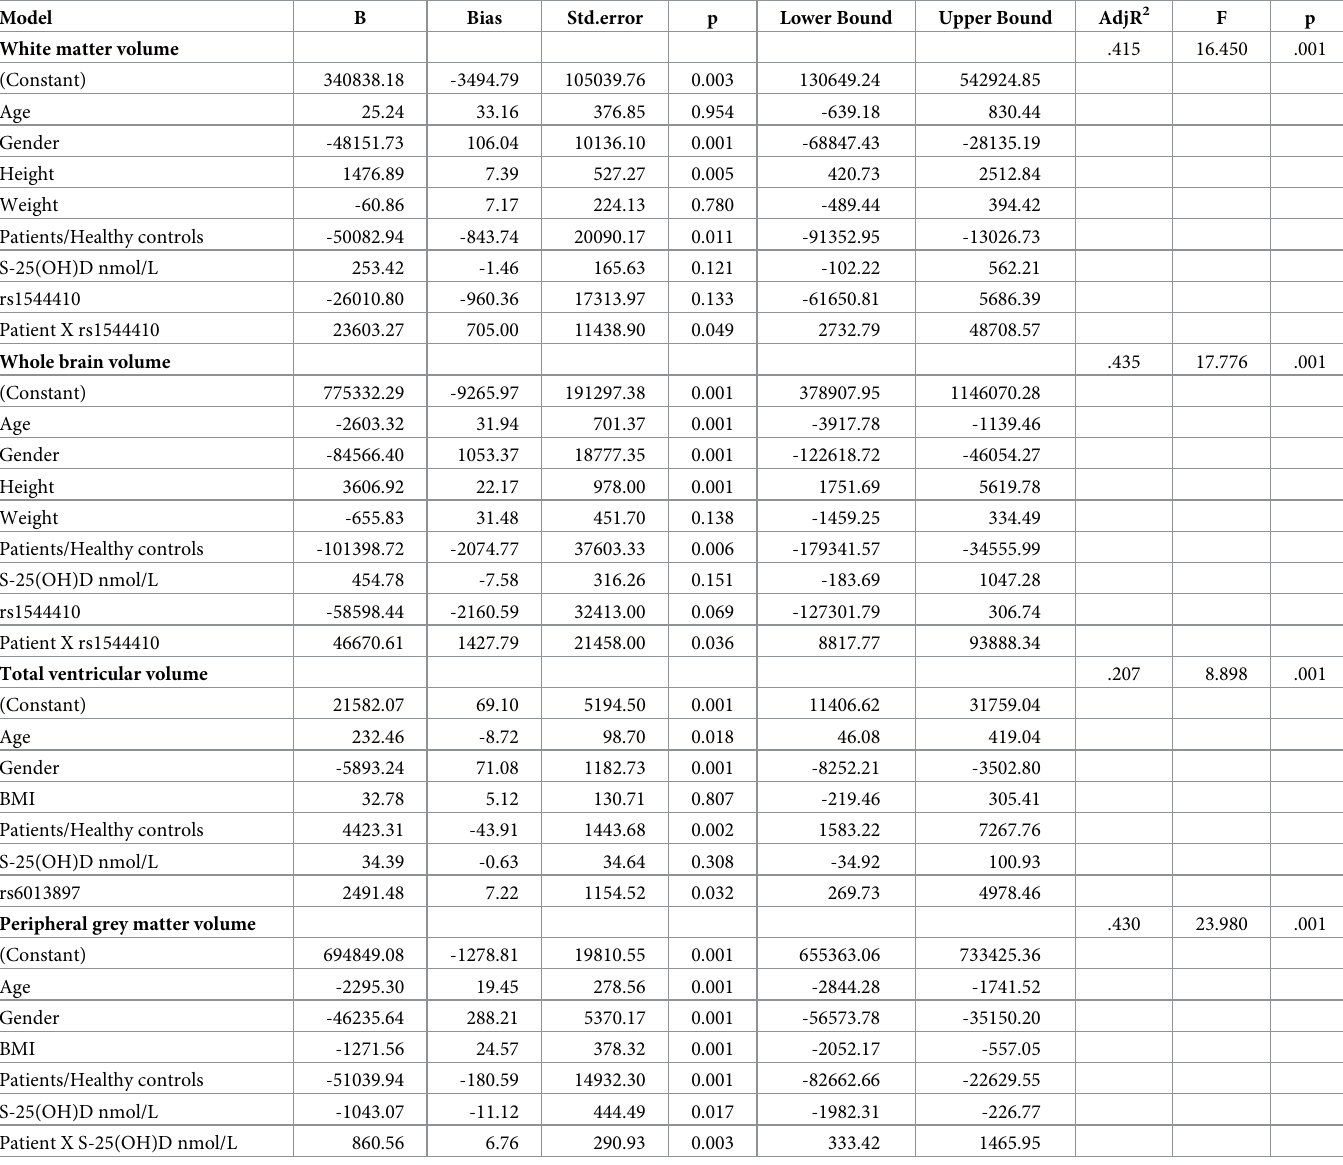
Table 5. Multiple linear regression models predicting white—and peripheral grey matter, whole brain—and total ventricular